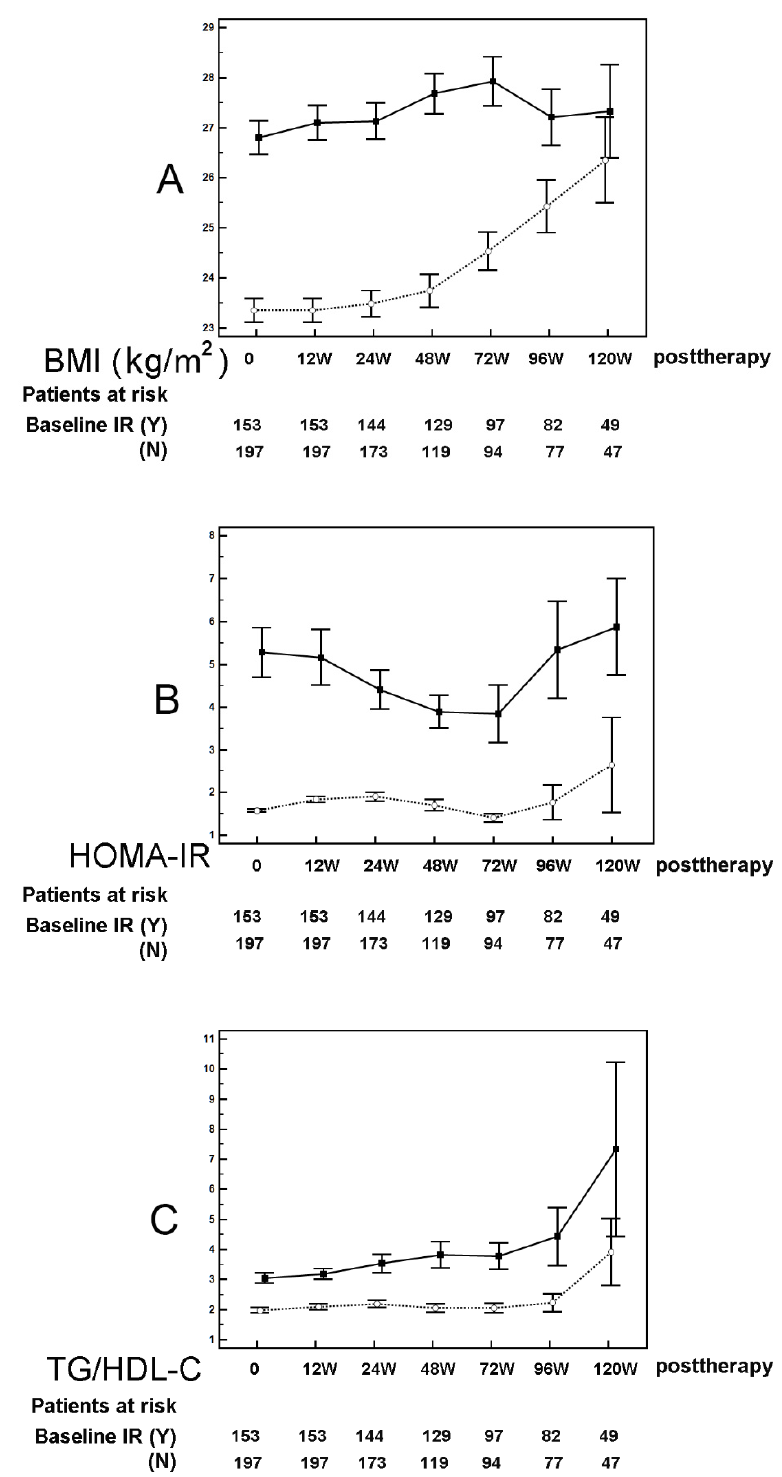
Figure 4. Longitudinal metabolic alteration of SVR patients stratified by baseline insulin resistance (IR). Mean ± standard error of BMI ( A ), HOMA-IR ( B ), and TG/HDL-C ratio ( C ). Time point: 0 represents baseline; W represents weeks after completion of anti-HCV therapy. Baseline IR (Y): SVR patients with baseline IR (solid lines); Baseline IR (N): SVR patients without baseline IR (dashed lines). The associated p values are shown in Table S5.